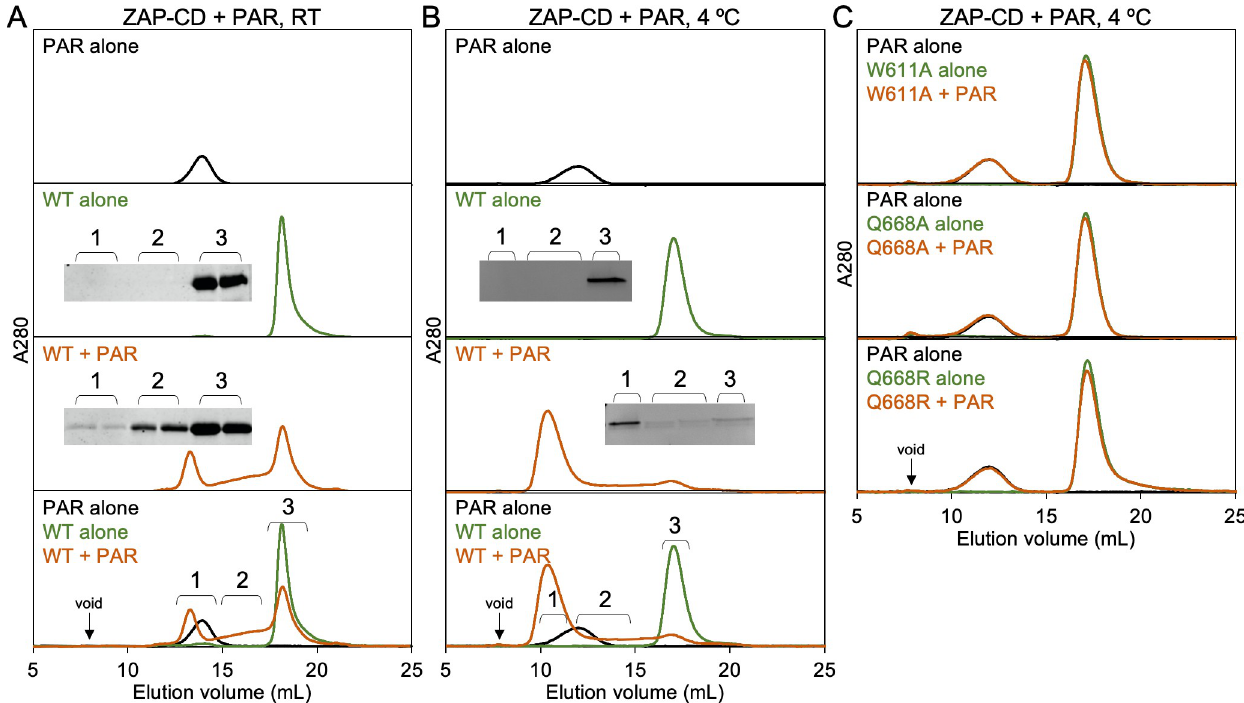
Fig 5. ZAP-CD binds to PAR in vitro . (A) Size exclusion binding assay with purified ZAP-CD and PAR, performed at room temperature. The three top panels show individual analytical Superdex 200 size exclusion profiles of purified PAR alone (black), ZAP-CD alone (green) and mixed ZAP-CD and PAR after 20 min incubation (orange). The bottom panel shows an overlay of all three curves. Insets show SDS-PAGE analysis of fractions indicated in the bottom panel. Results are representative of two independent experiments, each done in two replicates. (B) Size exclusion assay performed at 4˚C. Results are representative of two independent experiments. (C) Representative results of assays (4˚C) performed with the indicated ZAP-CD mutants. Results are representative of two independent experiments.